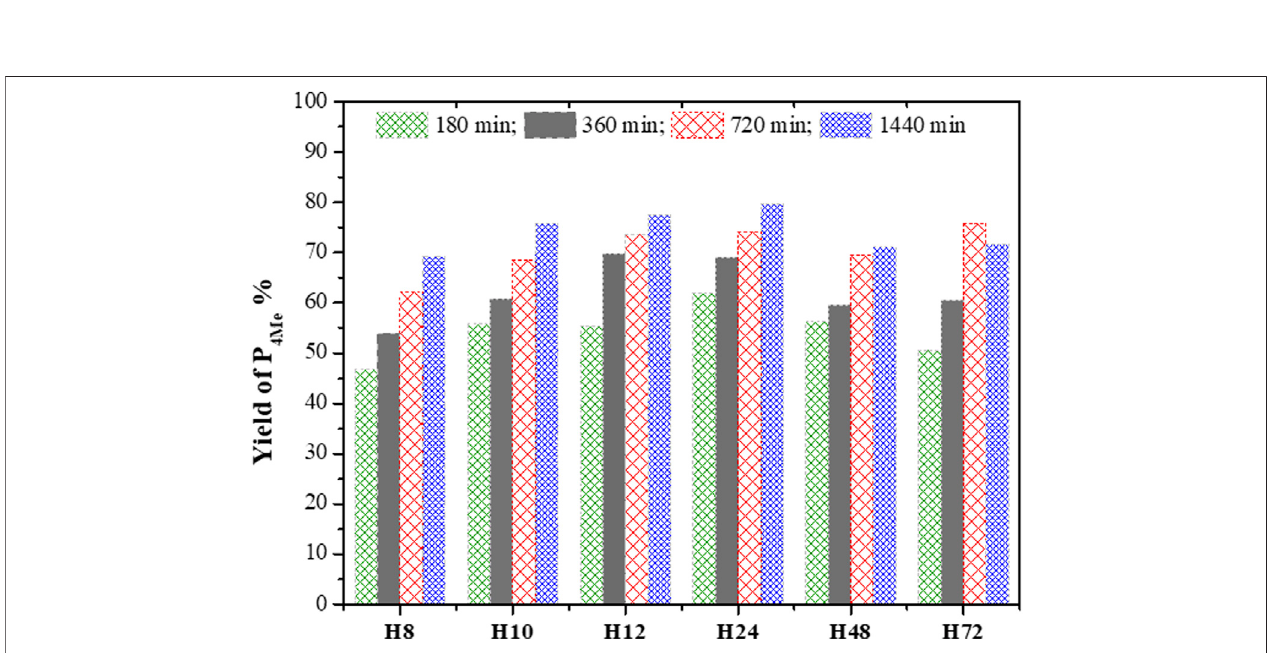
FIGURE12| PercentageyieldofP 4Me overCFA-basedHBEA zeolites(reactionconditions:temperature (cid:2) 120 ° C,maximumtime (cid:2) 1,440 min, anisole/BzCl ratio (cid:2) 2.5:1, and catalyst (cid:2) 0.068 g).